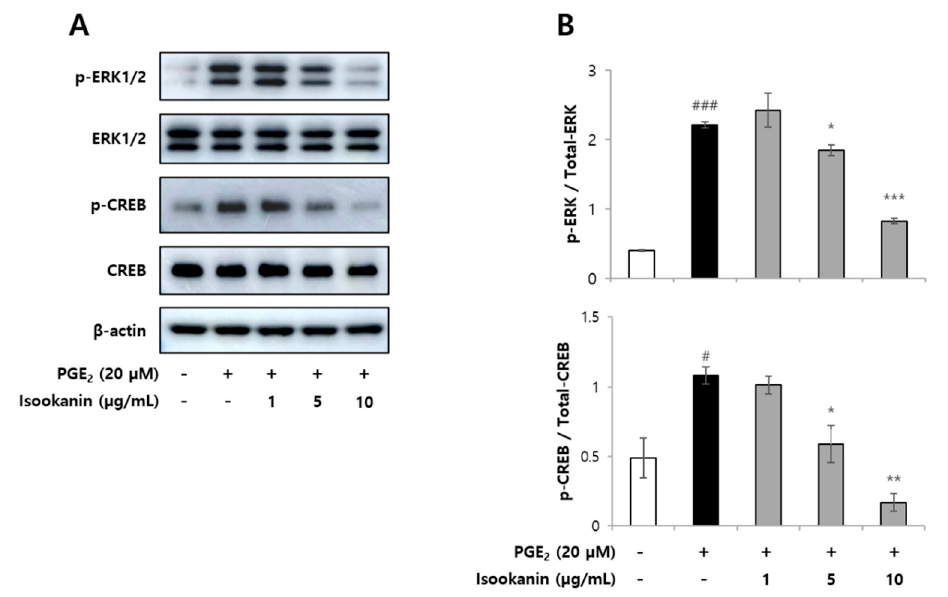
Figure 6. Effects of isookanin on the phosphorylation of ERK and CREB in PGE 2 -induced HMEC-1 cells. The HMEC-1 cells were cultured for 24 h and then treated with PGE 2 (20 µM) in the presence or absence of isookanin. Cell lysates were prepared at 20 min and were then subjected to Western blot analysis. ( A ) The bands for phospho-ERK1/2 and phospho-CREB were detected and normalized to their total forms of ERK1/2 and CREB. ( B ) The scanning densitometric values of each band were analyzed with Image J. The results are mean ± standard deviation (SD) ( n = 3). # p < 0.05, ### p < 0.001 vs. control. * p < 0.05, ** p < 0.01, * p < 0.001 vs. PGE 2 -treated control.